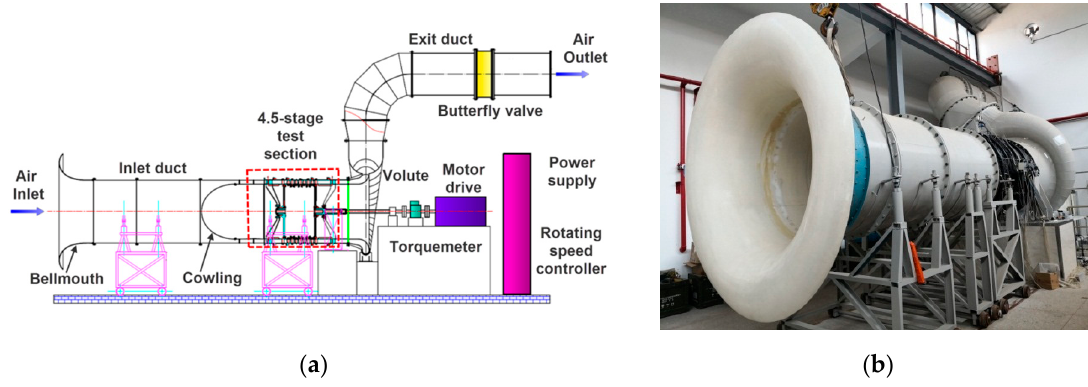
Figure 1. 4.5-stage low-speed research compressor (LSRC) test rig in NUAA (2018). ( a ) A sketch of compressor test rig ( b ) Photograph of the LSRC test rig. Table 1. Global parameters of the LSRC (2018) in NUAA.